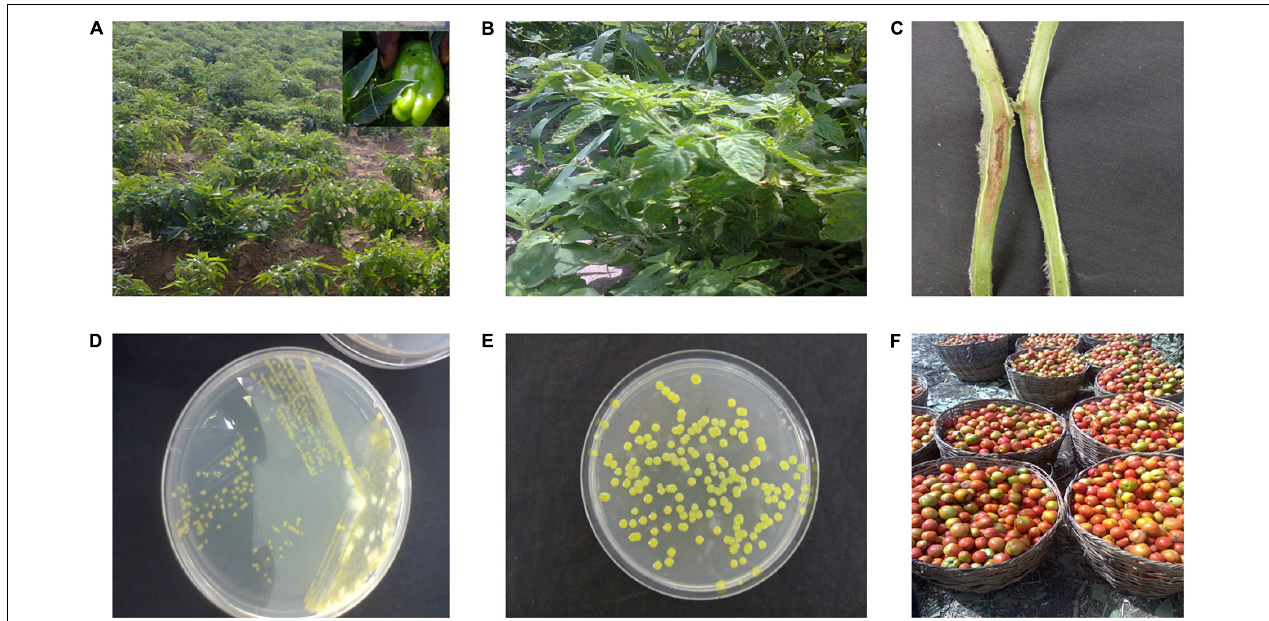
FIGURE 1 | (A) Pepper field in northwestern Nigeria infected with bacterial spot disease. Most pepper race 6 Nigerian strains (Jibrin et al., 2014) were isolated from this field. (B) Tomato field in Tanzania infected with bacteria spot disease. (C) Pith necrosis observed in tomato stem artificially inoculated with Xanthomonas perforans strain Xp91-118. (D) Quadrant streaking to isolate pure culture of bacterial spot strains from field samples of tomato. (E) Pure culture obtained after sub-culturing strain from (D) . (F) Typical harvest of tomato in Nigeria. Diseased fruits are separated from healthy fruits before